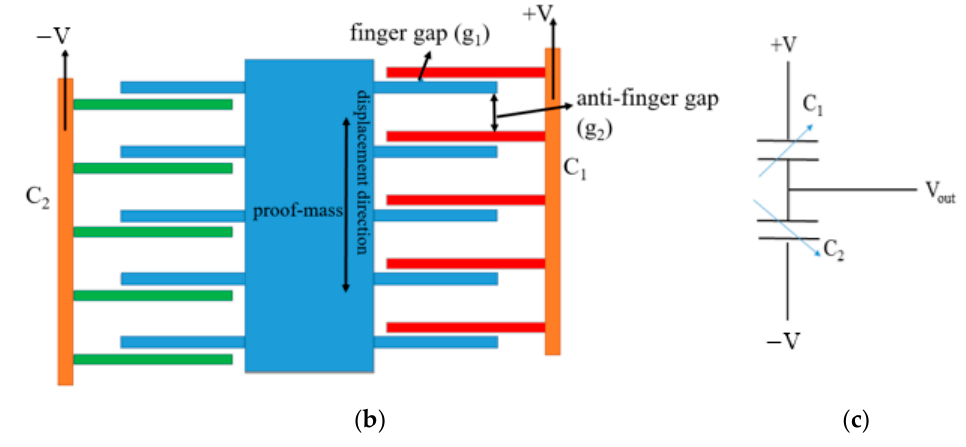
Figure 3. Sensing scheme of ( a ) area change accelerometer ( b ) gap change accelerometer ( c ) equivalent circuit.